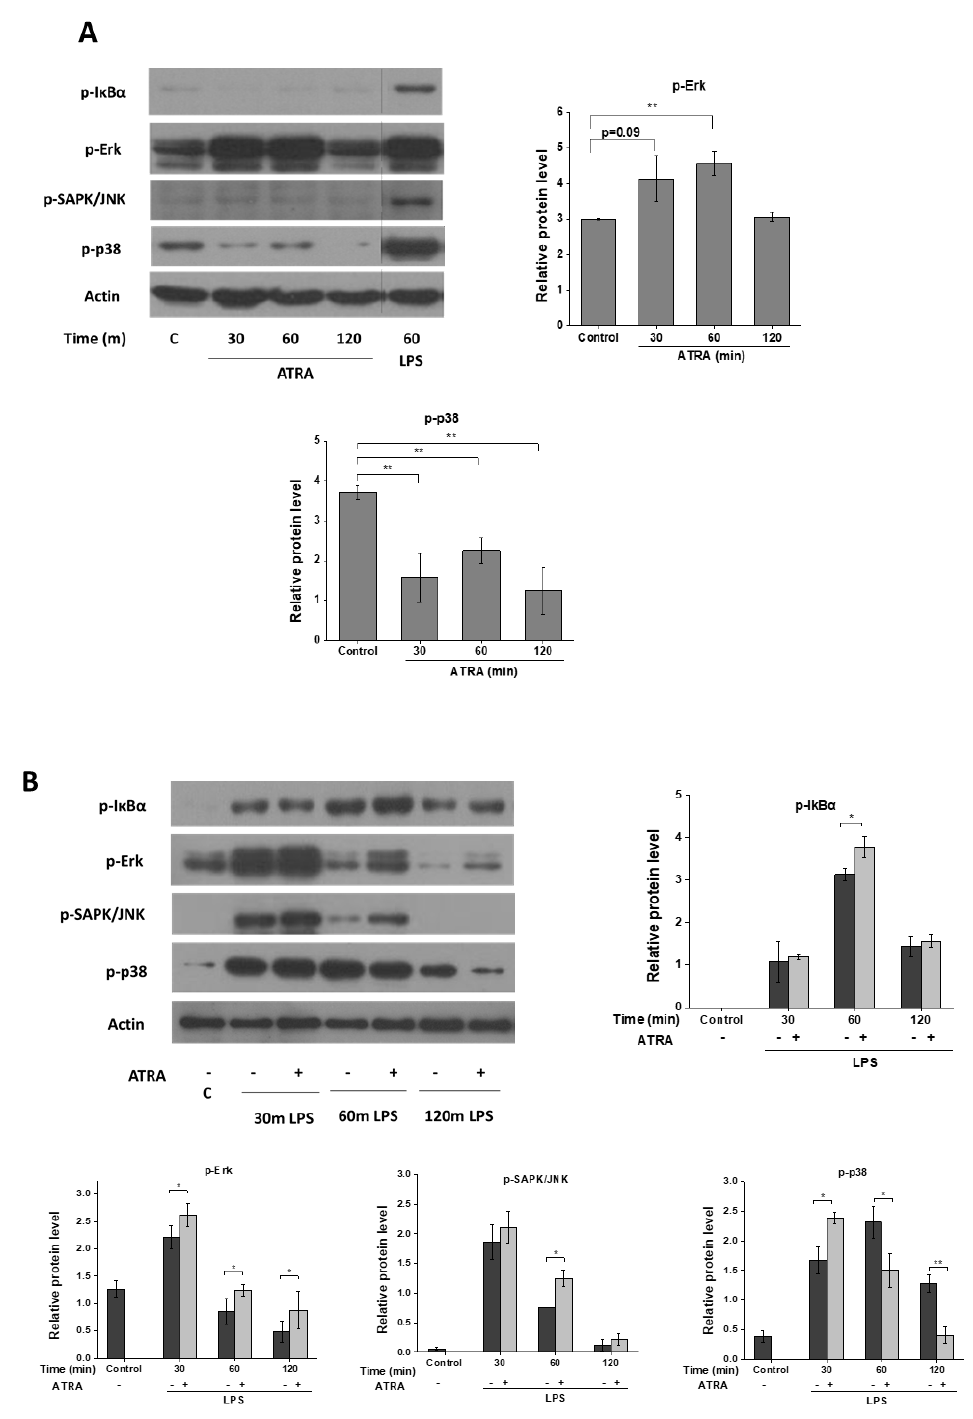
Figure 4. ATRA mediates signal transduction changes in M Φ s. ( A ) Representative immunoblots of phosphorylated IkB α , Erk, SAPK / JNK, and p38 from whole-cell lysates after ATRA treatment for the indicated time points. Here, 60-min LPS-primed cells served as a positive control. ( B ) M Φ s were pre-incubated with ATRA (1 µ M) prior to LPS priming for the indicated time, and phosphorylated IkB α , Erk, SAPK / JNK, and p38. β -actin was used as the internal control. C, control (mock-treated cells). The data were obtained from at least four healthy donors. All results are shown as means ± SEM. (* p < 0.05, ** p < 0.01). + , − , presence or absence of indicated substance,